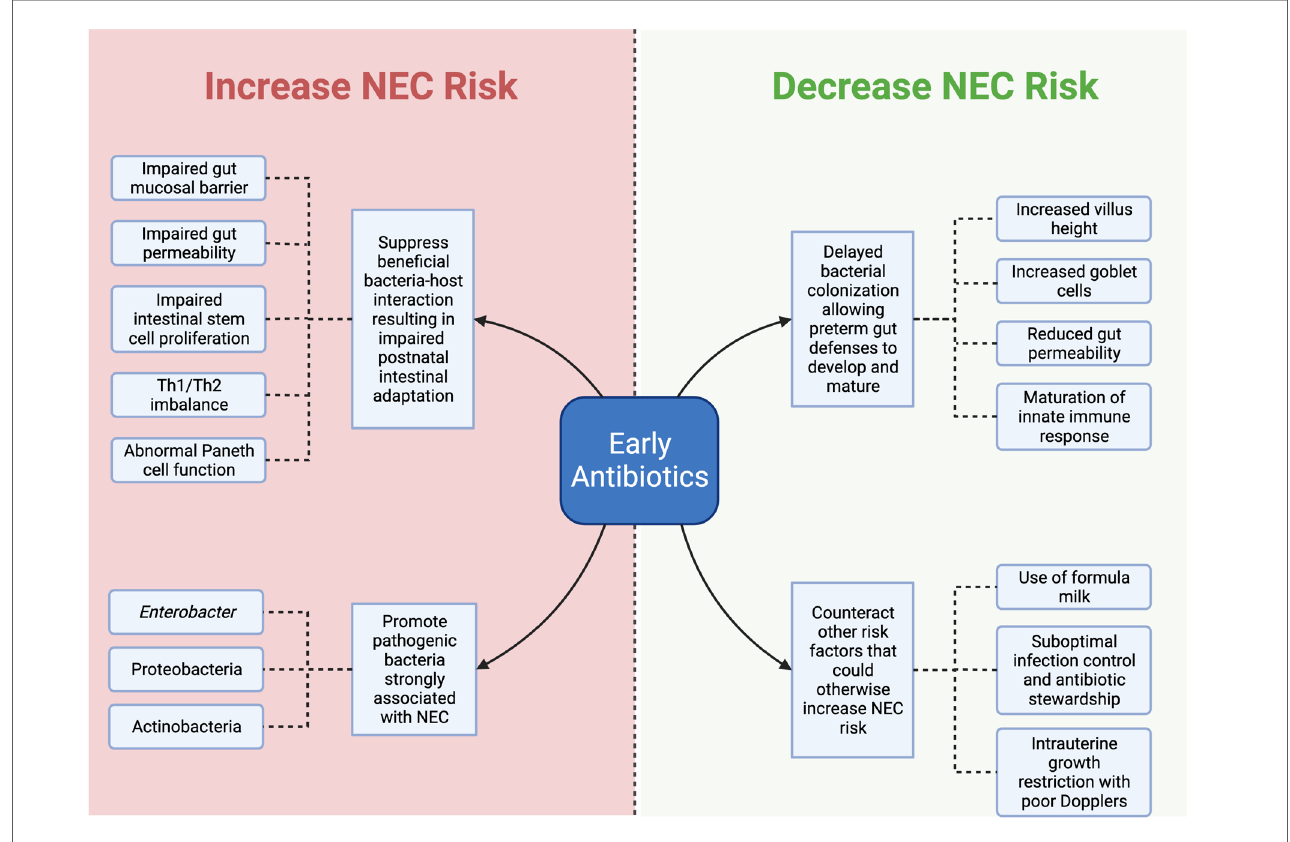
FIGURE 1 Diagram of potential mechanisms by which early antibiotics can increase or decrease NEC risk. Created with